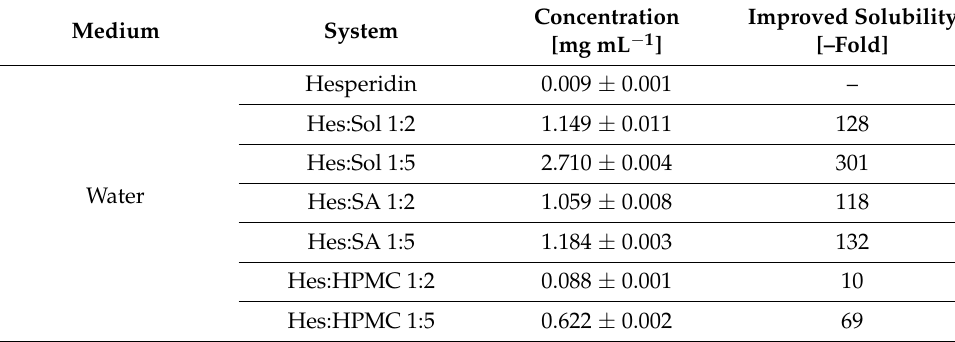
Table 2. Solubility of hesperidin in amorphous dispersion with